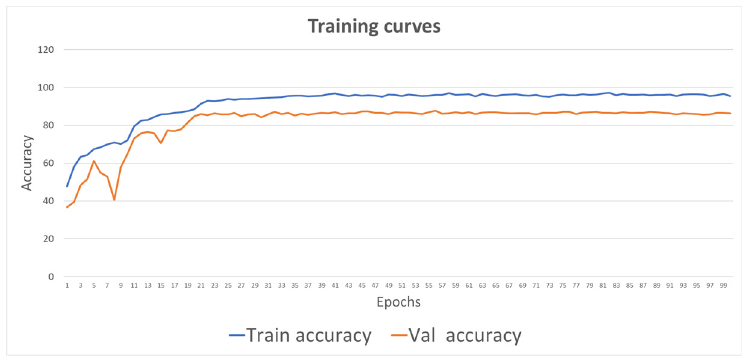
Figure 7. Training curves for SIFT-CNN when trained for the lip-reading task.